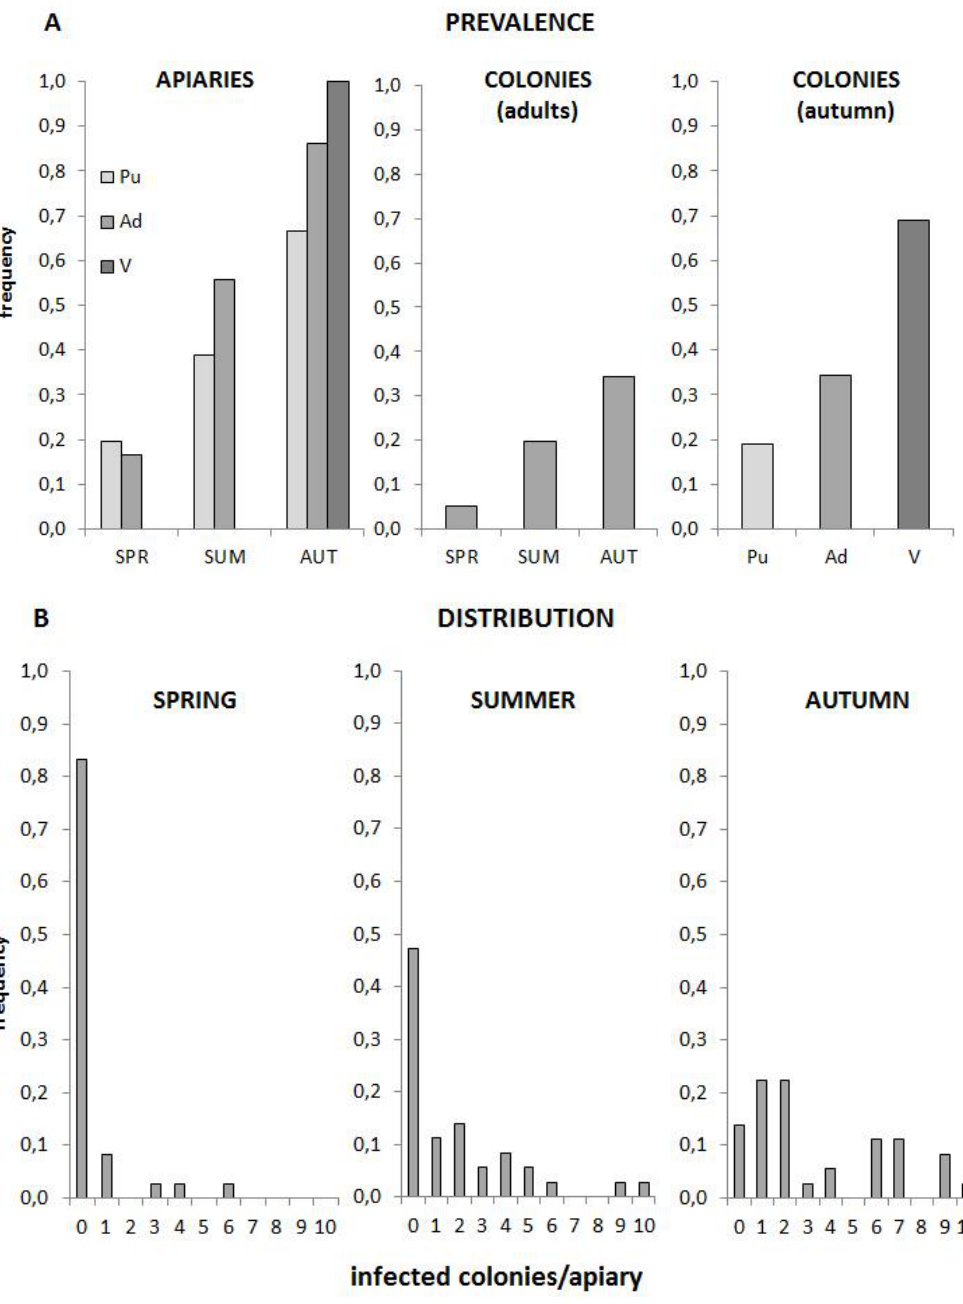
Figure 3. ( A ) Prevalence of BeeMLV in A. mellifera pupae (light grey), adults (medium grey) and V. destructor (dark grey) collected during Spring, Summer and Autumn of